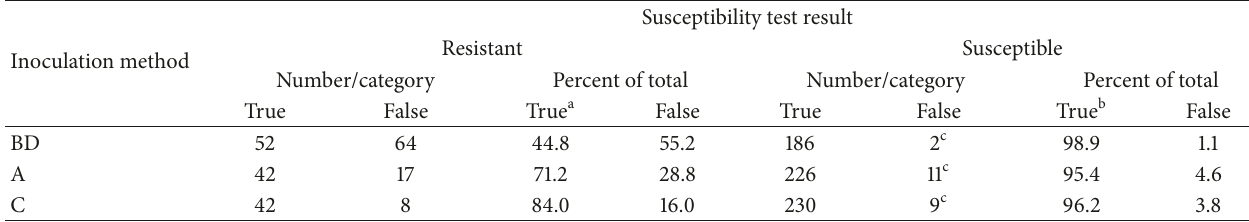
Table 3: Summary of categorical MGIT PZA susceptibility test results stratified by possible outcome and inoculation method.